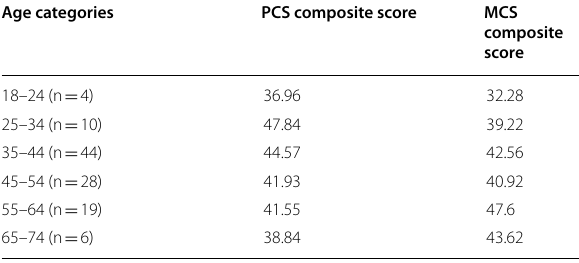
PCS physical component summary, MCS mental health component summary